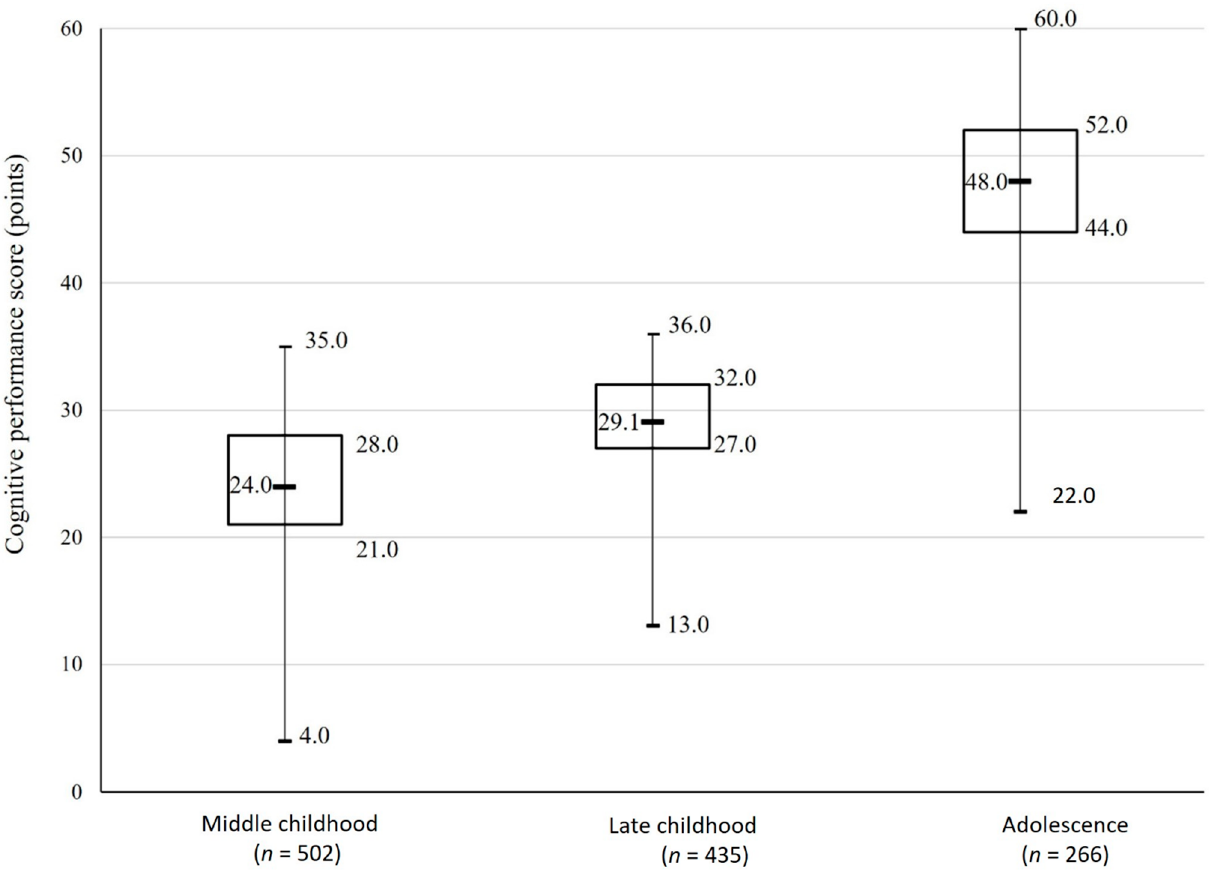
Figure 1. Participants’ cognitive performance during middle childhood, late childhood and adoles- cence.